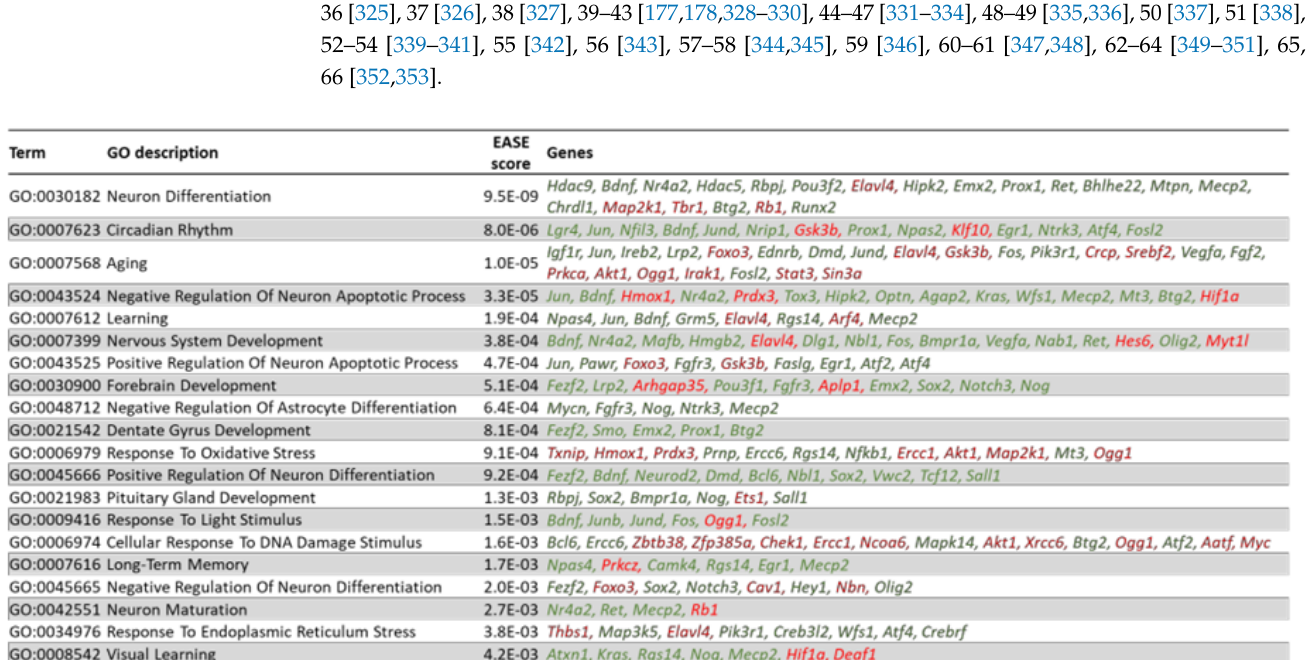
Figure 16. Biological processes controlled by the Arc-dependent transcriptional regulators. The top 20 biological processes of neurological relevance are listed. EASE score is a modified Fisher exact p-value measuring the gene-enrichment in the annotated terms. Genes are arranged in order of highest to lowest absolute fold change. Genes highlighted in red are upregulated, while those highlighted in green are downregulated.